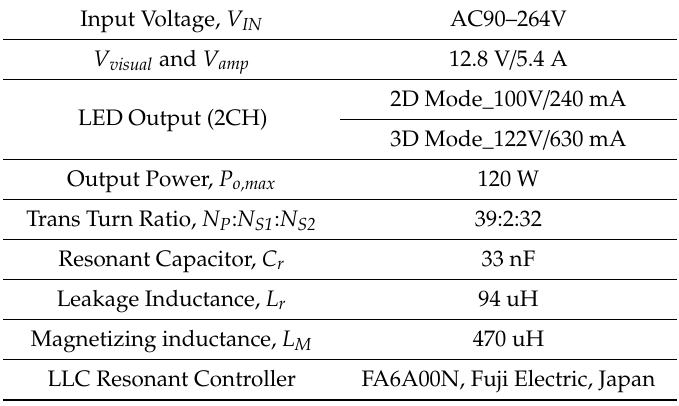
Table 1. Design and circuit specification for power